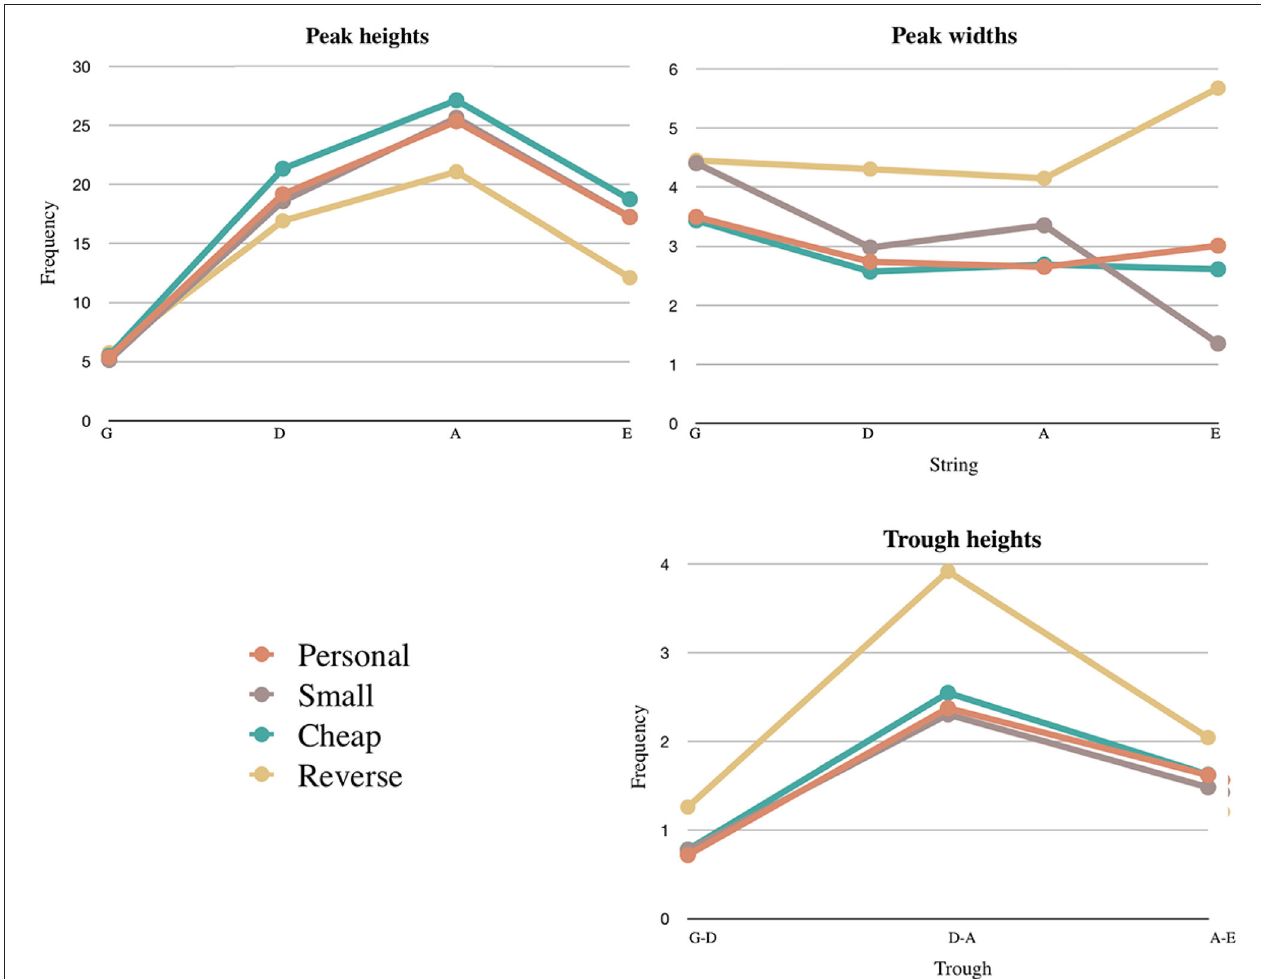
FIGURE 9 | Means of the peak heights, widths, and troughs for each instrument. This data accounts for the reversing of the strings on the last